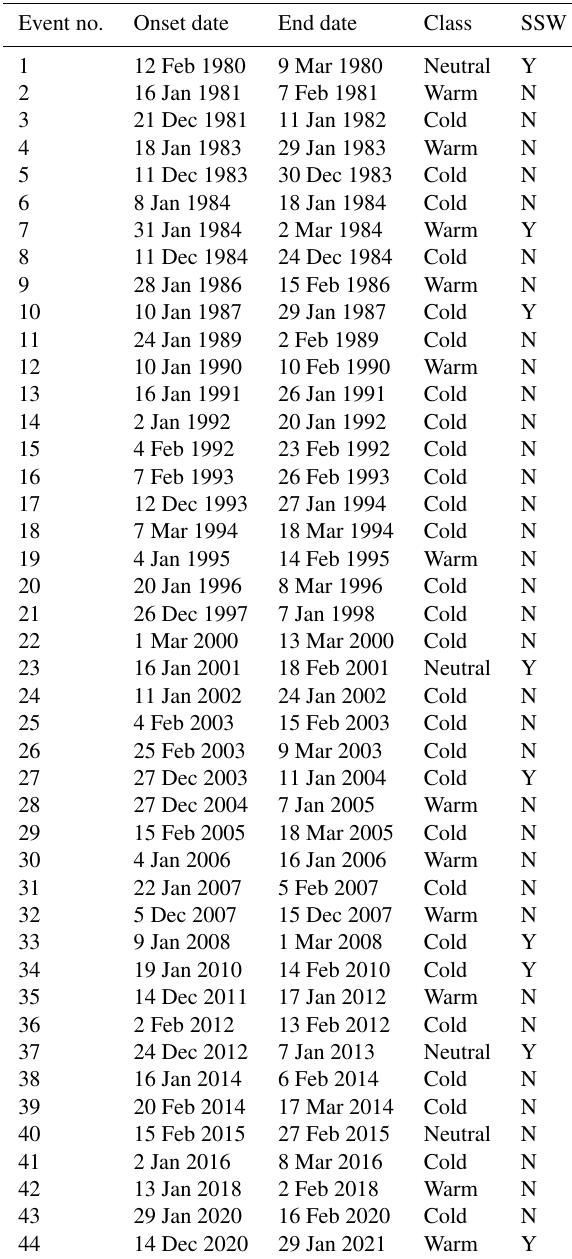
Table A1. Onset and end dates, temperature classification, and SSW coincidence for the 44 selected stratospheric reflection events. An SSW is considered to coincide with a reflection event if the dates of the two events overlap. We used the SSW catalogue from NOAA Chemical Sciences Laboratory (2020) and the additional event described in Lee (2021). For the SSWs in NOAA Chemical Sciences Laboratory (2020) only those present in at least two reanalysis products were